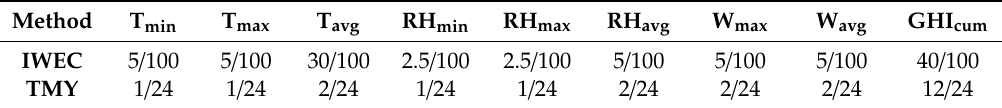
Table 2. Non-dimensional weighting factors according to di ff erent procedures (T: Dry bulb temperature; RH: Relative humidity; W: Wind speed; GHI: Global horizontal